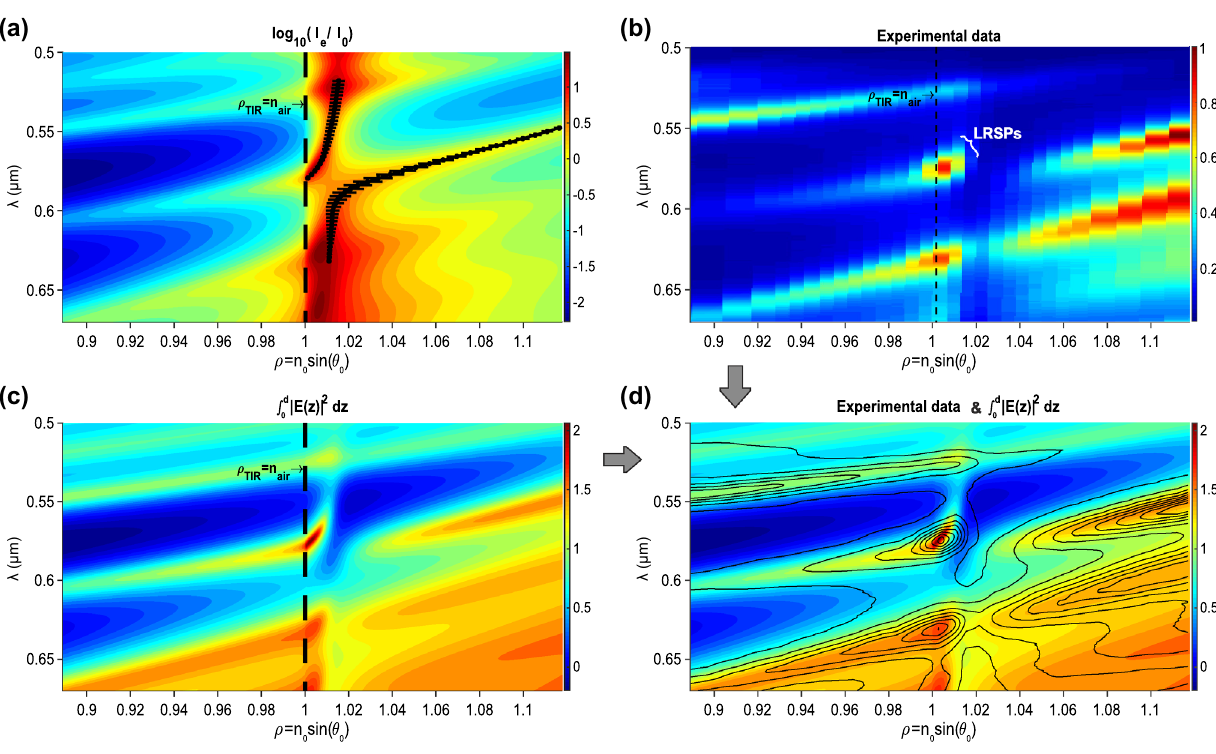
Fig. 3 Dispersion plots of the light-emitting structure under study: a calculated intensity enhancement at the external surface (in a logarithmic color scale), and the dispersion curves of surface modes for a semi-infinite 1D PC (black lines, the error bar represents the imaginary part of ϱ ), b the stack of 29 experimental spectra of electroluminescence taken at different angular parameters ϱ , c calculated integral of the optical elec- tric field in the Super Yellow layer, and d superimposed experimental spectra (as smoothed contour lines) and the integral of the optical elec- tric field in the SY layer. (Color figure